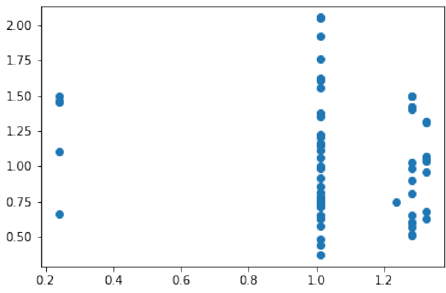
Figure 7 . Pattern (10 , 15 , 1 , 32 , 5) with k = 500 and eigenvalues found by the gradient descent (before re-inverting g ). x -axis is the eigenvalue which takes values at (1.32, 1.28, 1.236, 1.01, 0.24), and y -axis is the b -score. We see a modest negative ( − 0 . 145 )